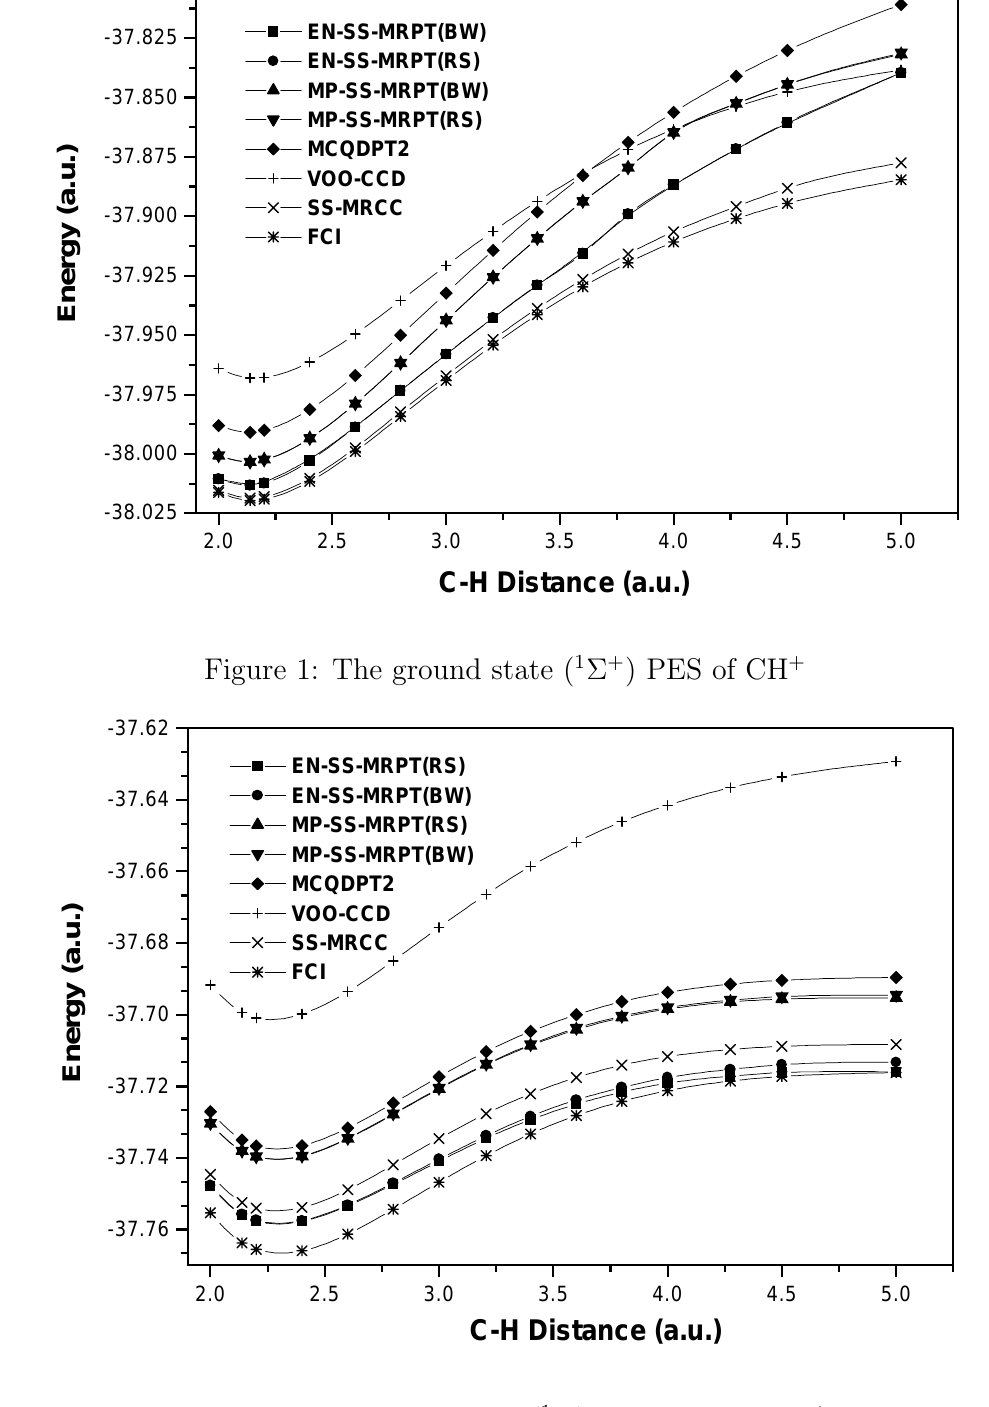
Figure 2: The first excited ( 1 ∆) state PES of CH